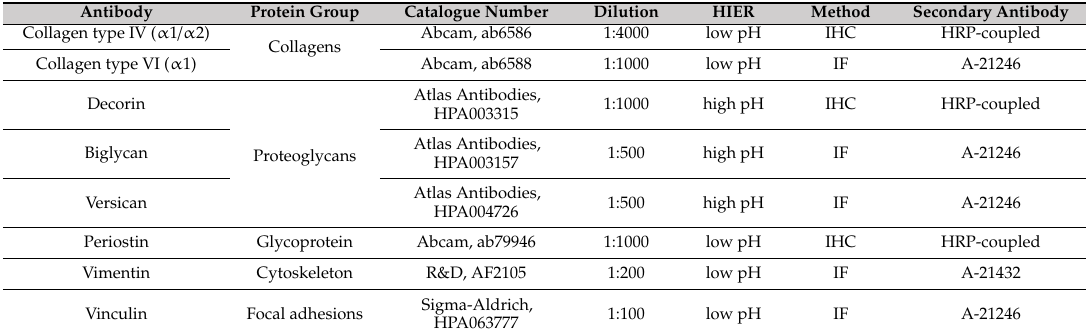
Table 2. Antibody